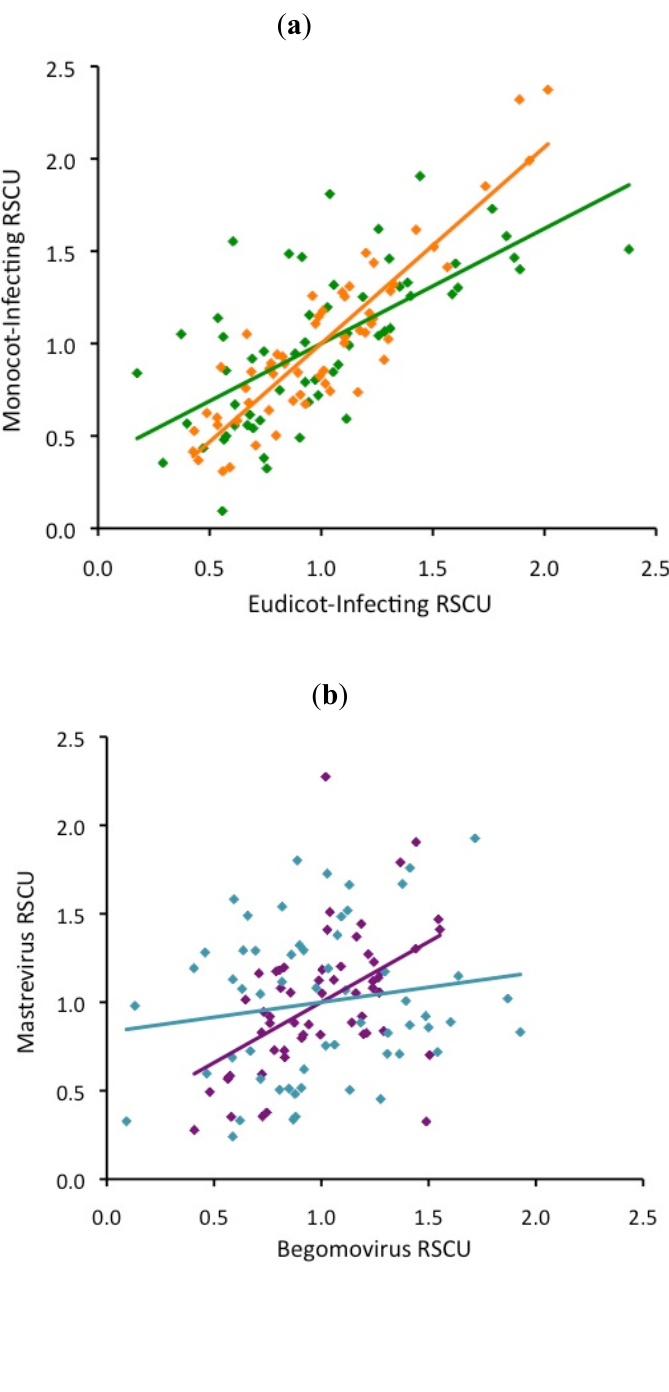
Figure 4. Correlation of relative synonymous codon usage (RSCU) between (a) monocot and eudicot-infecting potyvirus CPs (orange), luteovirus CPs (green) and (b) begomo- and mastrevirus CPs (aqua) and begomo- and mastrevirus Reps